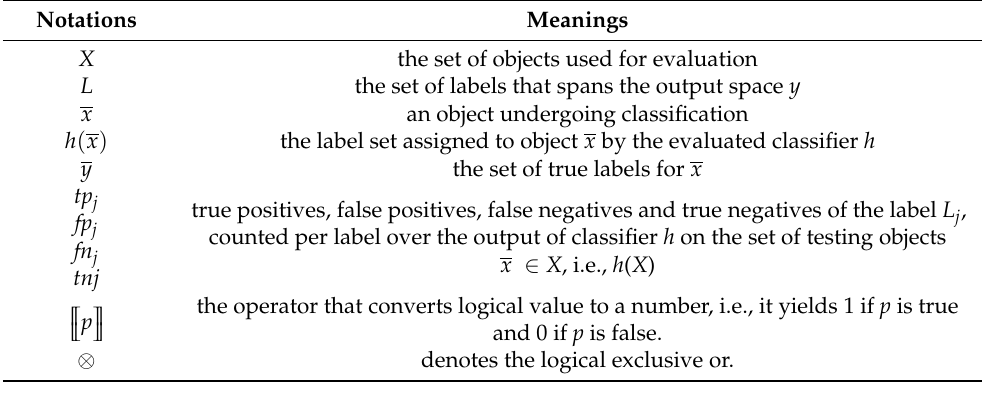
Table 1. Definition of notations.